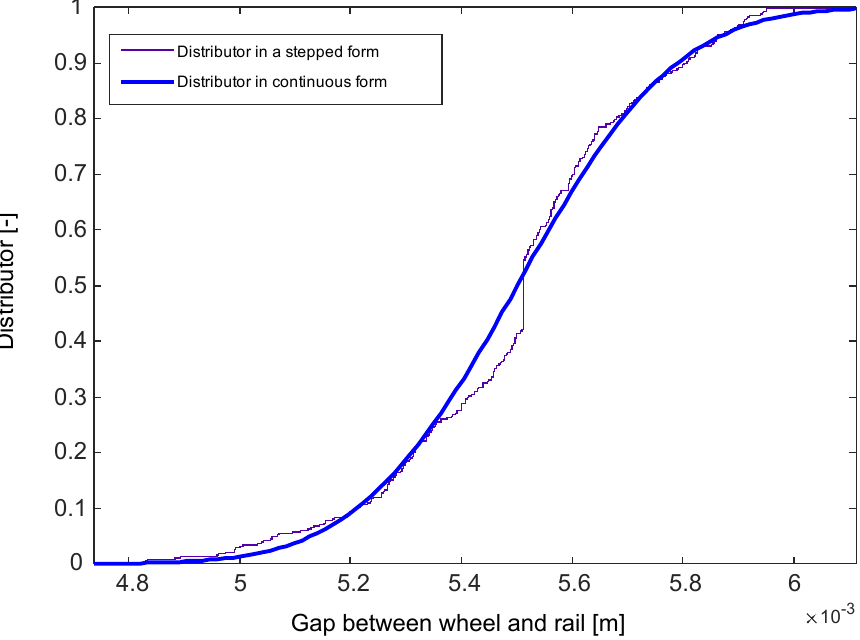
Figure 10. Distribution function for a wheel–rail gap in the rail turnout.